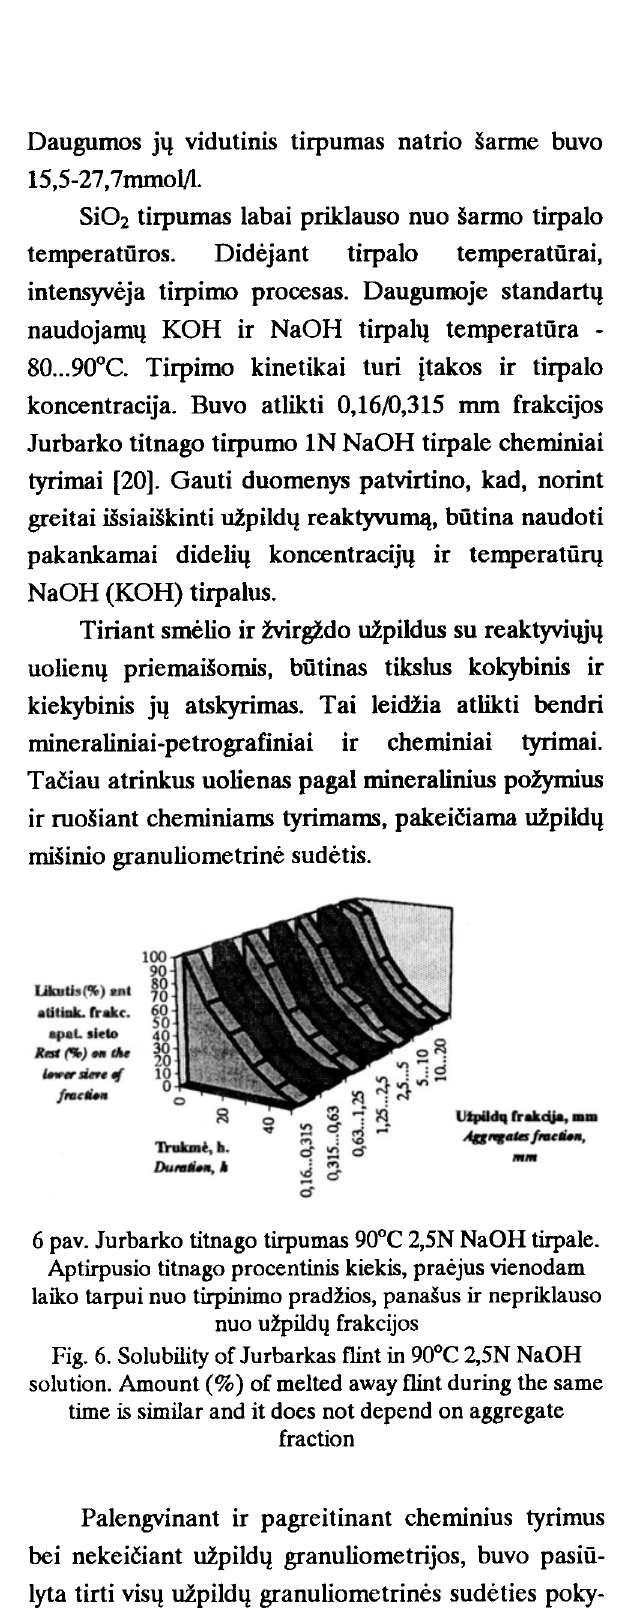
Fig. 6. Solubility of Jurbarkas flint in 90°C 2,5N NaOH solution. Amount(%) of melted away flint during the same time is similar and it does not depend on aggregate fraction